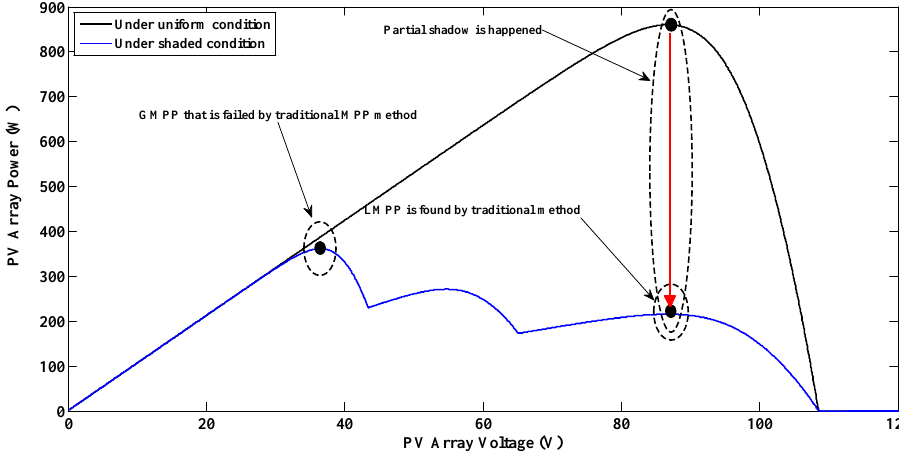
Figure 4. Failure of the maximum power point tracking (MPPT) algorithm to find the global maximum power point